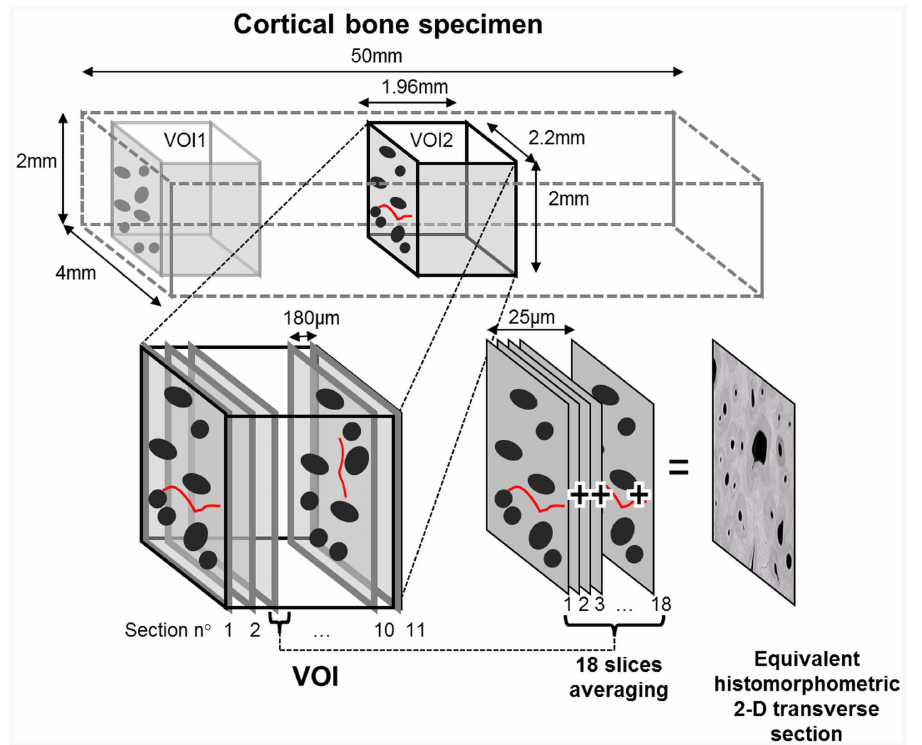
Figure 3. Diagram illustrating the process leading to an equivalent histomorphometric 2-D transverse cross-section image from 3- D reconstructed bone volumes acquired by SR- m CT.